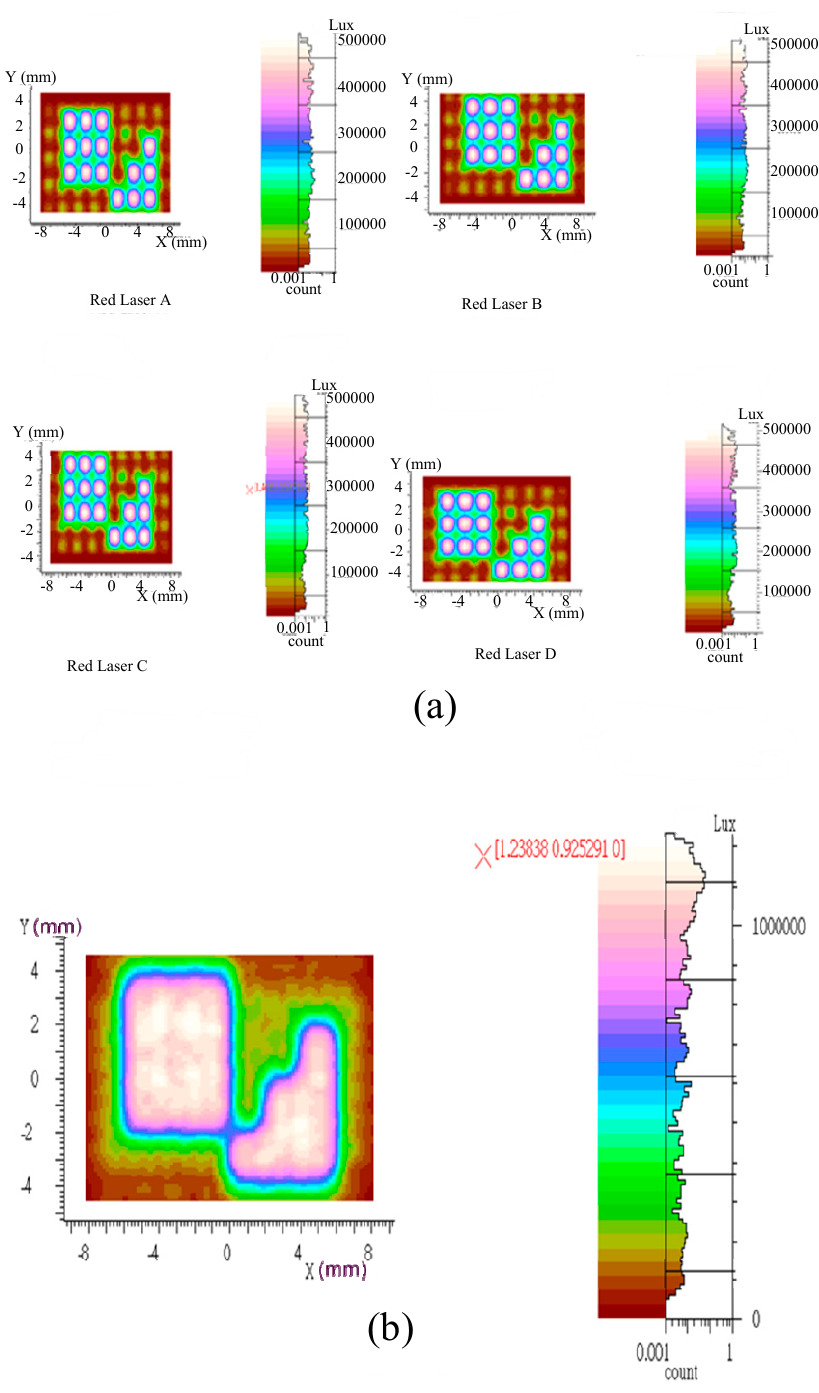
Figure 11. ( a ) Single red laser, displaying displacement map for local dimming (liquid crystal lens with pore size of 2.0 mm and a focal length of 9 cm). ( b ) Four red lasers, displaying compensation for light source micro scanning (liquid crystal lens with pore size of 2.0 mm and a focal length of 9 cm).